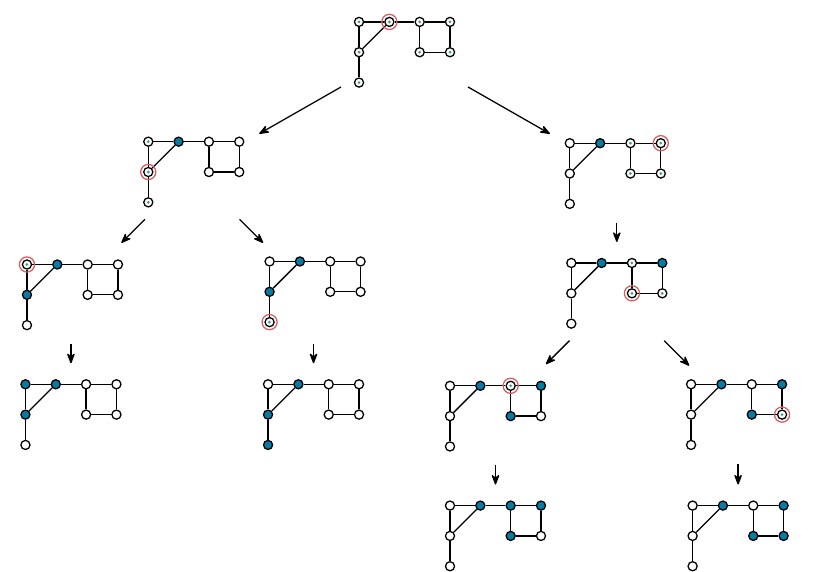
Figure 2. An illustration of the graph searching game for treedepth on the 8 vertex graph shown at the very top. Vertices that contain a green dot are currently contaminated . The searchers will place a searcher on the vertex with a red circle in the next round. The cleaned vertices (on which a searcher stands) are filled with blue. The arrows indicate the various choices of the fugitive. The diagram proves that 4 searchers have a winning strategy on this specific graph.